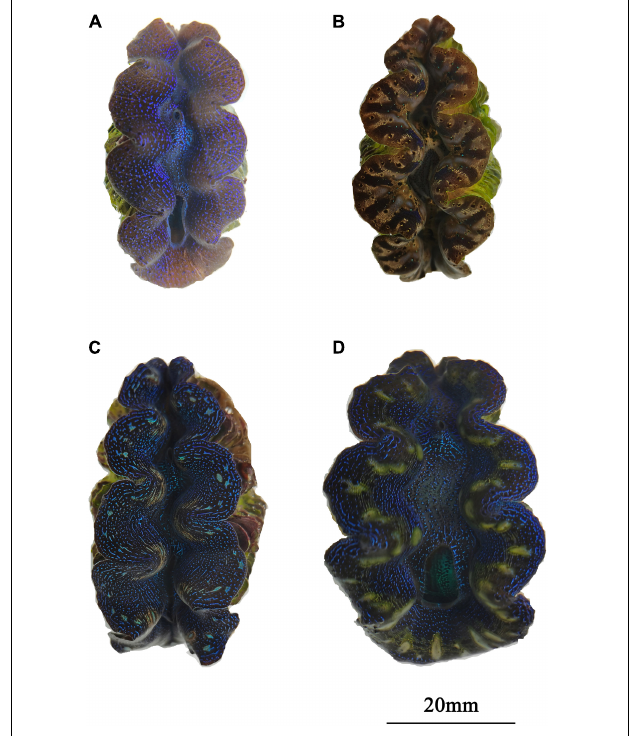
FIGURE 1 | Photos of progeny for boring giant clam Tridacna crocea . (A) BB progeny. (B) YY progeny. (C) BY Progeny. (D) YB Progeny. The bar indicates 30 mm, and it applies to all samples in Figure 1